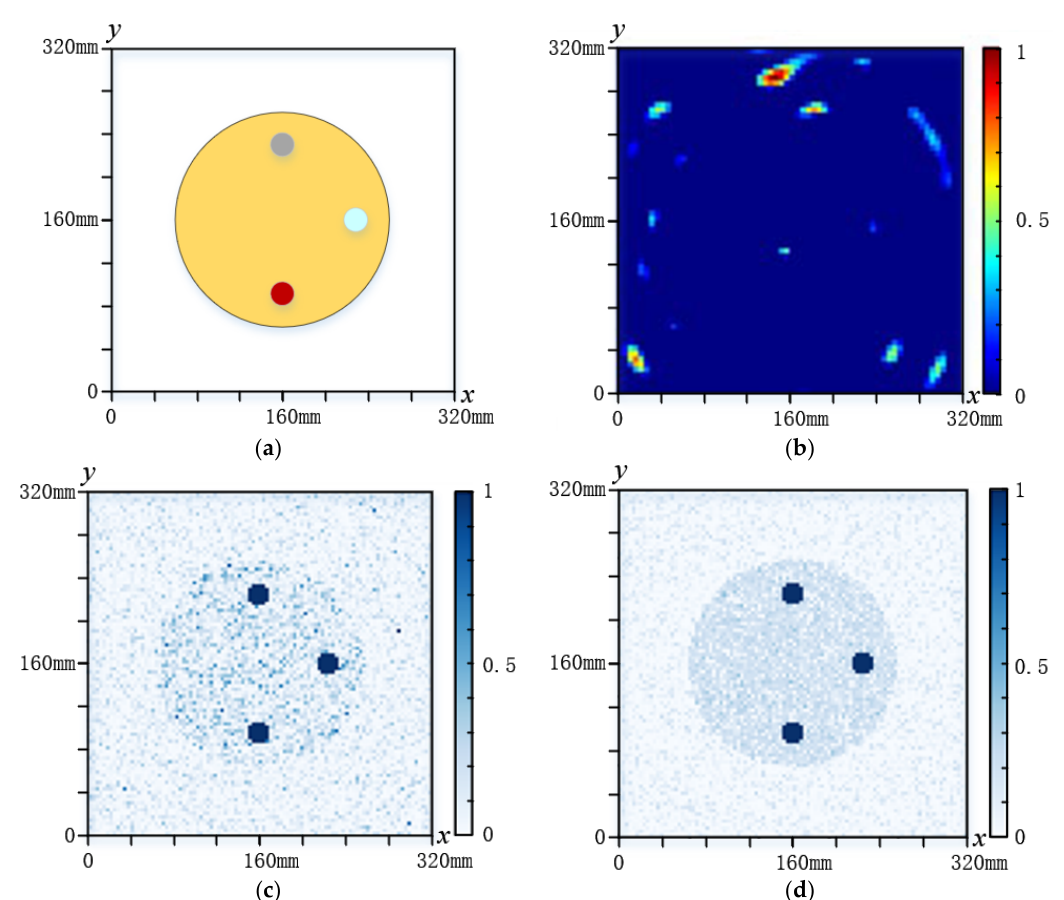
Figure 6. Heterogeneous multi ‐ defect model inversion imaging. ( a ) Heterogeneous multi ‐ defect model with 2cm radius. ( b ) CSI inversion results. ( c ) BP neural network inversion results. ( d ) Model ‐ driven deep learning network inversion results.